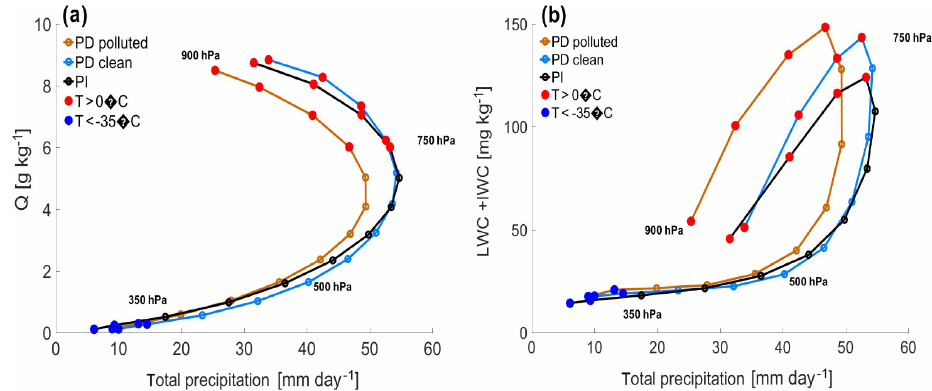
Figure 5. Phase diagram for the three categories of WCB trajectories: PD polluted (orange), PD clean (blue) and PI (black). (a) Mean specific humidity ( q ) and (b) mean total condensate (LWC + IWC) as function of total precipitation; values are shown for 50hPa thick vertical layers, from 900 to 300hPa. The 750 and 350hPa levels are marked and the red (blue) dots denote temperatures above 0 ◦ C (below − 35 ◦ C).